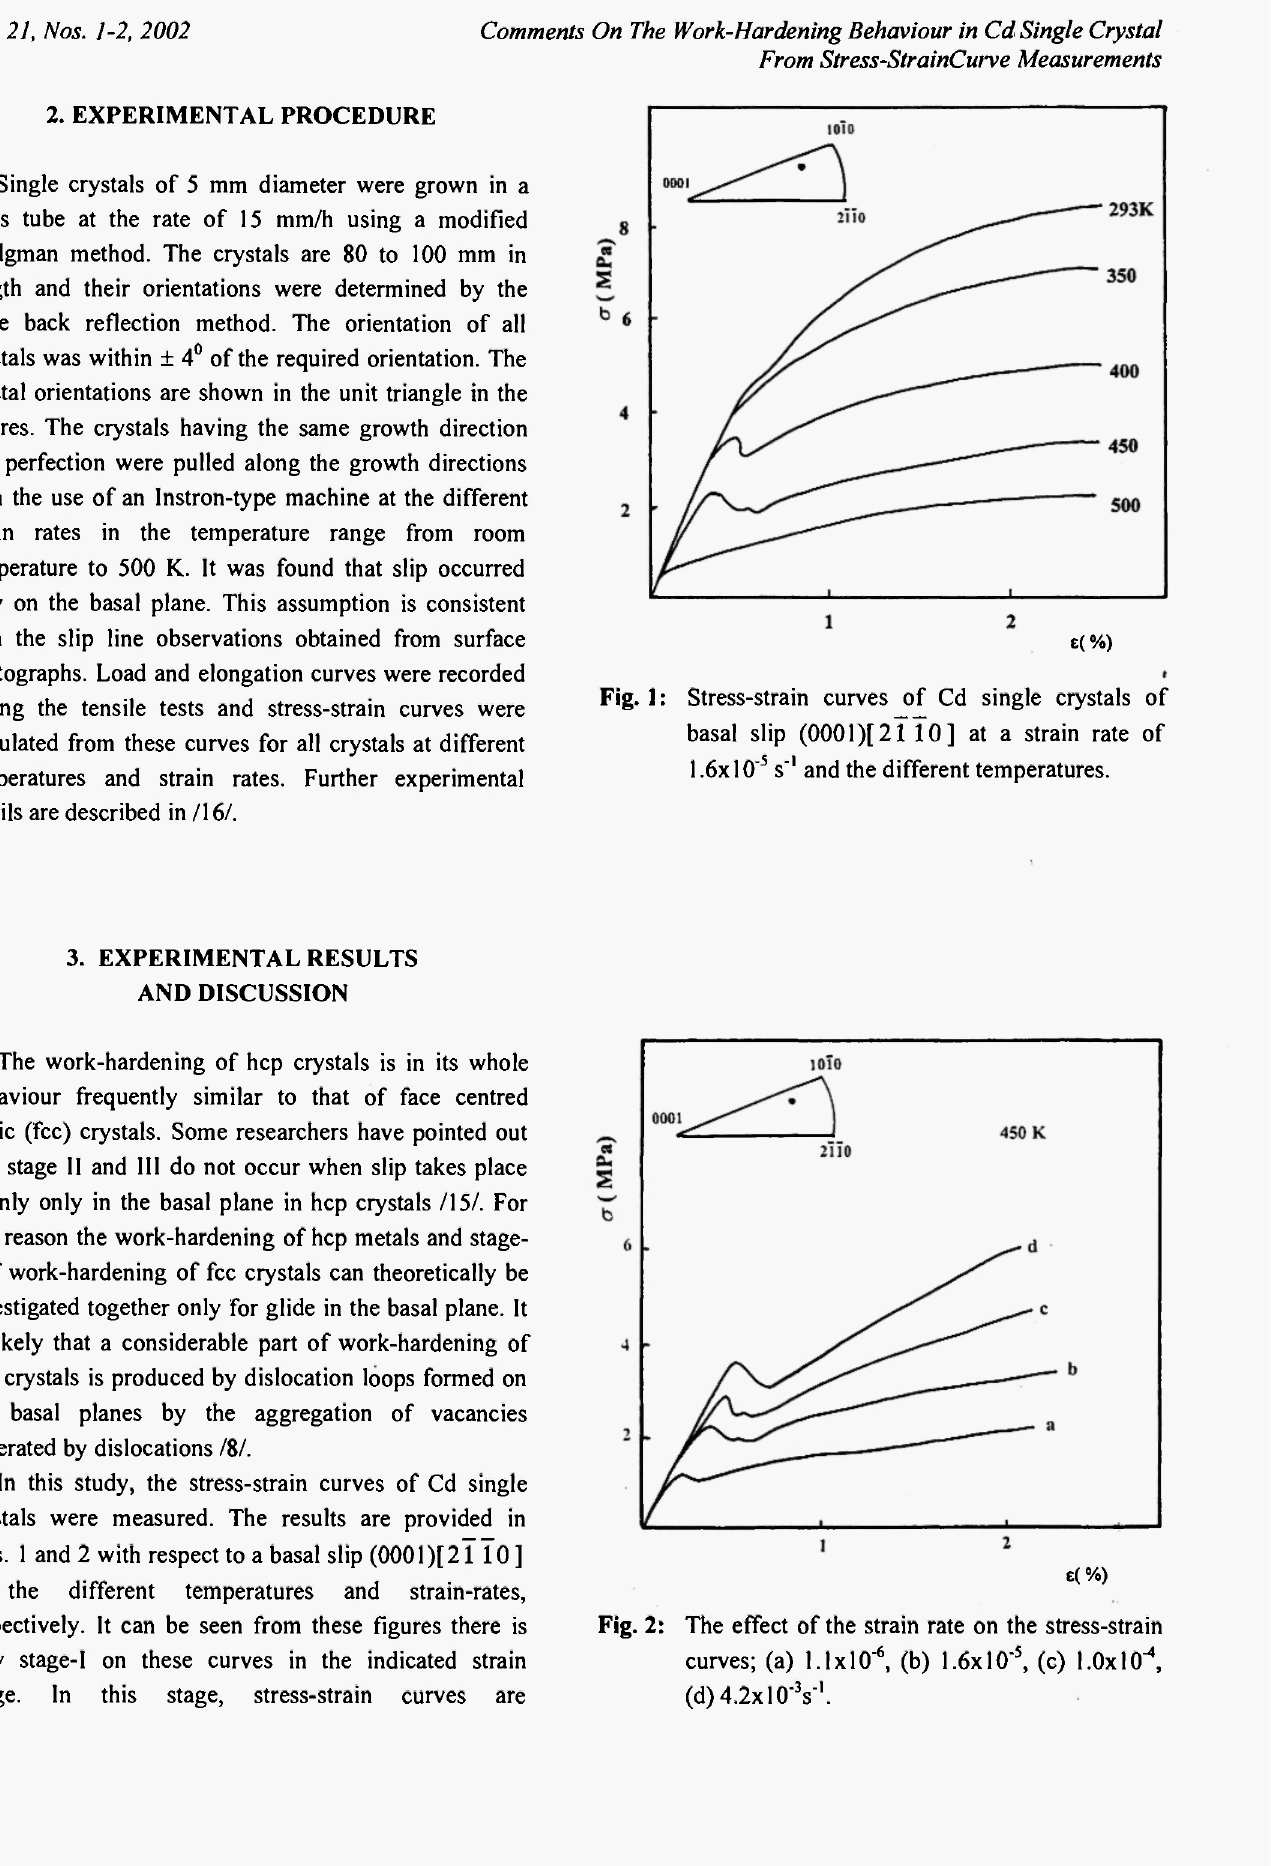
Fig. 2: The effect of the strain rate on the stress-strain curves; (a) l.lxlO" 6 , (b) 1.6x10 -5 , (c) l.OxlO" 4 , curves are